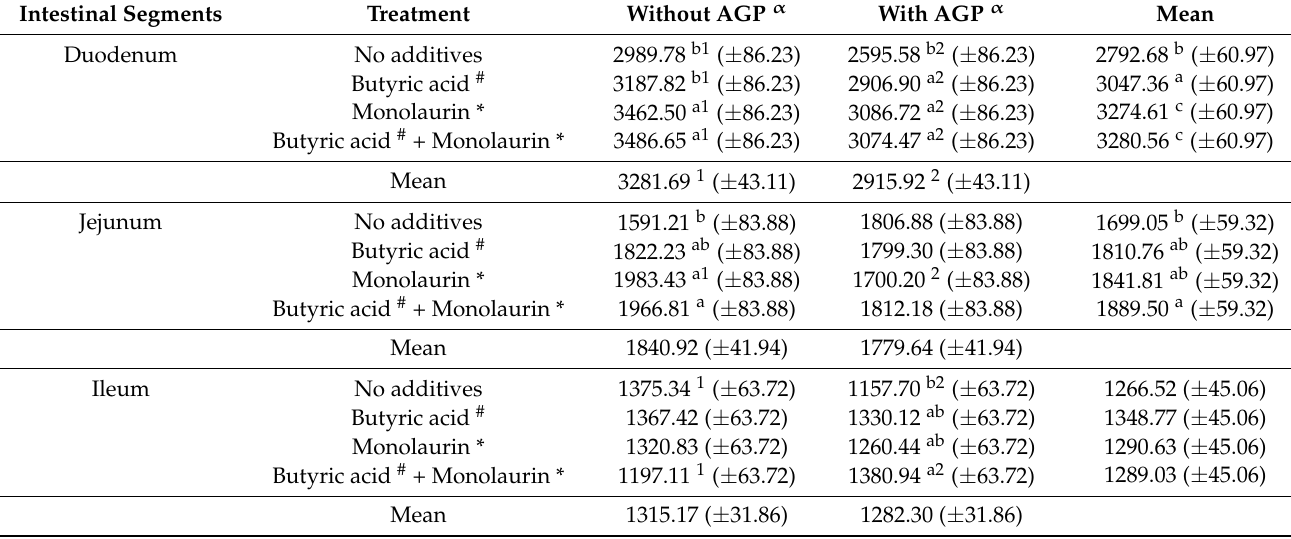
Table 5. The effect of butyric acid and α -monolaurin, with and without the inclusion of antibiotic growth promoters, on the villi height ( µ m) of the duodenum, jejunum and ileum of broilers at 33 days of age ( ± standard error of the mean).